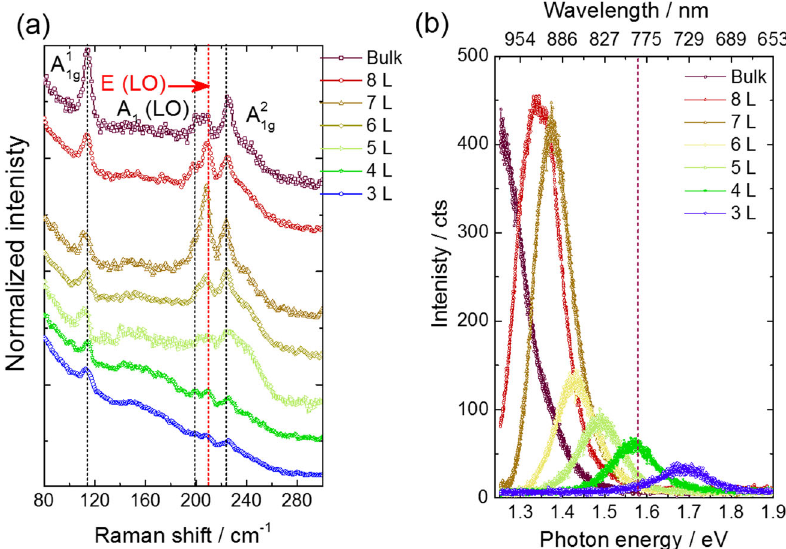
Fig. 4 Layer-dependent Fröhlich interaction in InSe. Layer dependent ( a ) Raman spectra excited at 1.58 eV and ( b ) corresponding photoluminescence spectra of InSe. There is a drastic drop of intensity of the polar LO modes from 7 to 6 L corresponding to the thickness where the direct to indirect bandgap transition of InSe